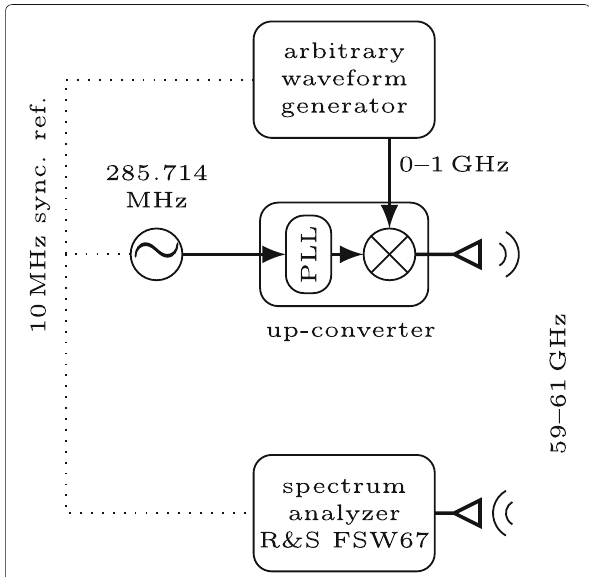
Fig. 9 RF set-up for MC2. The VNA from Fig. 6 is replaced with an AWG and an SA. This leads to a set-up where we obtain phase information as well. An option of the SA gives us direct access to the baseband IQ